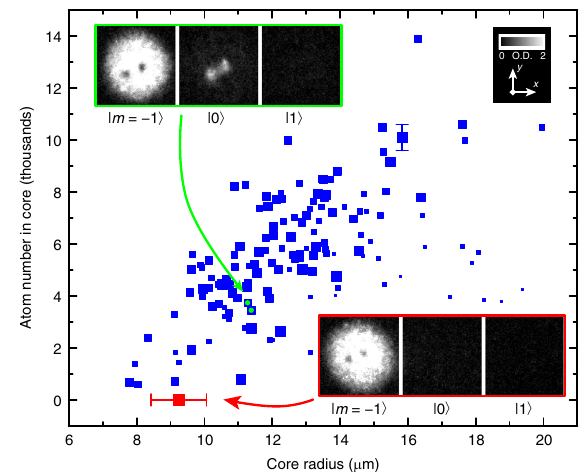
Fig. 6 Effect of the core atoms on the size of the core. The post-expansion size of the vortex cores in the m = − 1 component with un fi lled (red) or fi lled (blue) cores. The core size depends in part on the number of |0 〉 atoms within the core, which grows as |0 〉 atoms accumulate there. Each blue point represents a single vortex measurement. As even empty vortex cores near the condensate boundary are enlarged, we indicate the radial position of a vortex by the size of the point, with smaller points corresponding to larger radii. A typical uncertainty in the atom number within the core is given as a vertical error bar for a single point. The red point and error bar illustrate the mean and standard deviation of a representative sample of un fi lled vortex cores from more than 25 condensates, produced with a low-speed (|d B b /d t | < 1 G s − 1 ) ramp of the magnetic bias fi eld. The insets show typical experimental atomic density pro fi les from absorption imaging, expressed in terms of dimensionless optical depth (O.D.), of the three spinor components for the case of fi lled (upper left, and points marked with green circles) and empty (lower right) cores. The fi eld of view of each image in the insets is 219 μ m × 219 μ m. Source data are provided as a Source Data fi ^ d ¼ (cid:2) cos β ^ ρ þ sin β ^ z , where ^ ρ is the radial vector orthogonal to it is